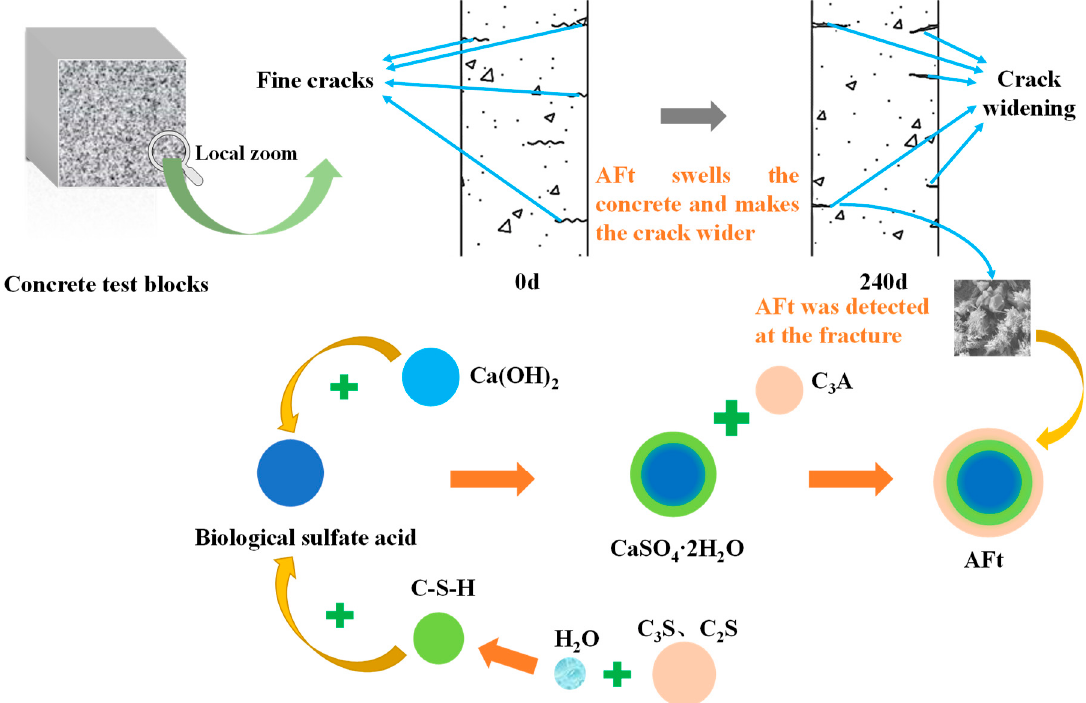
Figure 10. Concrete damage mode. Schematic diagram of the action model of sodium methyl silicate: